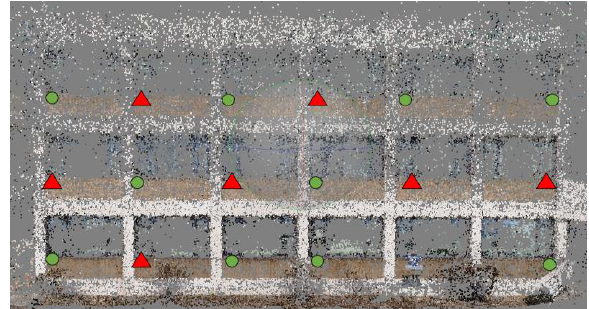
Figure 6. Red triangles are check points from the total-station, and Green dots are tie points between pictures of RTK drone and action camera.